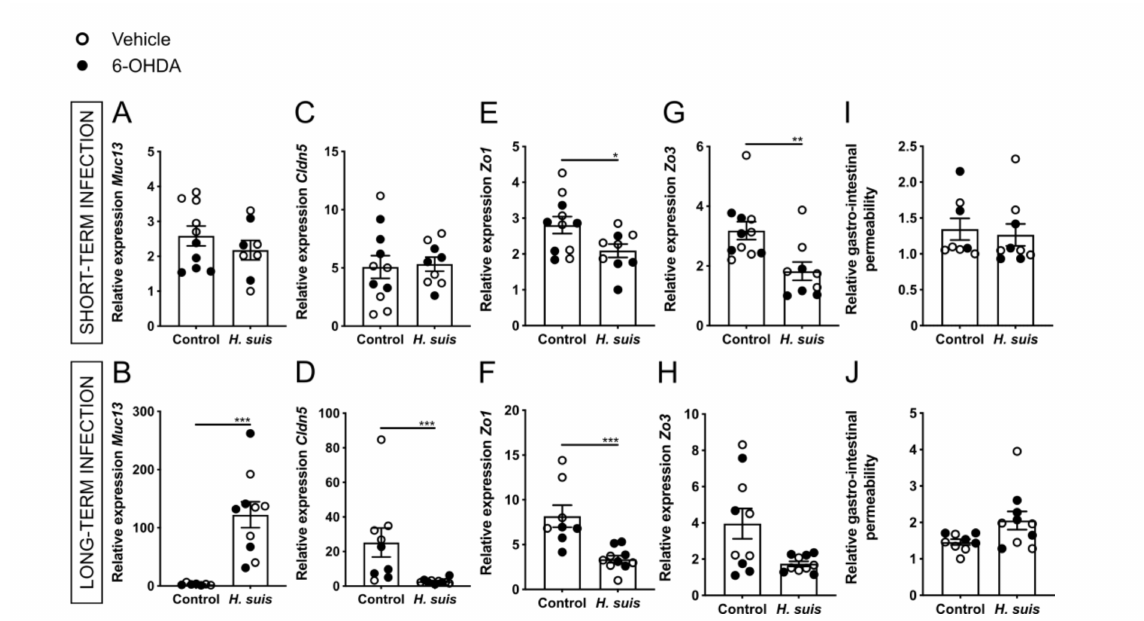
Figure 3. Gastric Helicobacter suis ( H. suis ) infection is associated with a limited decrease in integrity of the gastrointestinal barrier. ( A , B ) Relative mRNA gene expression of the mucin Muc13 in the corpus of the stomach of mice infected with H. suis or the control broth for a short- (n = 8–10) ( A ) or long-term period (n = 7–10) ( B ), 7 days after intrastriatal injection with either 6-OHDA (black) or vehicle (white). ( C – H ) Relative expression of the tight junction genes claudin 5 ( Cldn5 ) ( C , D ), zonula occludens 1 ( Zo1 ) ( E , F ), and zonula occludens 3 ( Zo3 ) ( G , H ) in the corpus of the stomach of mice infected with H. suis or the control broth for a short- (n = 9–11) ( C , E , G ) or long-term period (n = 8–10) ( D , F , H ). ( I , J ) Relative gastrointestinal permeability based on the 4 kDa FITC-dextran leakage assay of control mice compared to mice infected with H. suis for a short- (n = 8–9) ( I ) or long-term period (n = 9–10) ( J ). Data were analyzed by the Mann–Whitney test. * 0.01 ≤ p < 0.05; ** 0.001 ≤ p < 0.01; *** 0.0001 ≤ p <